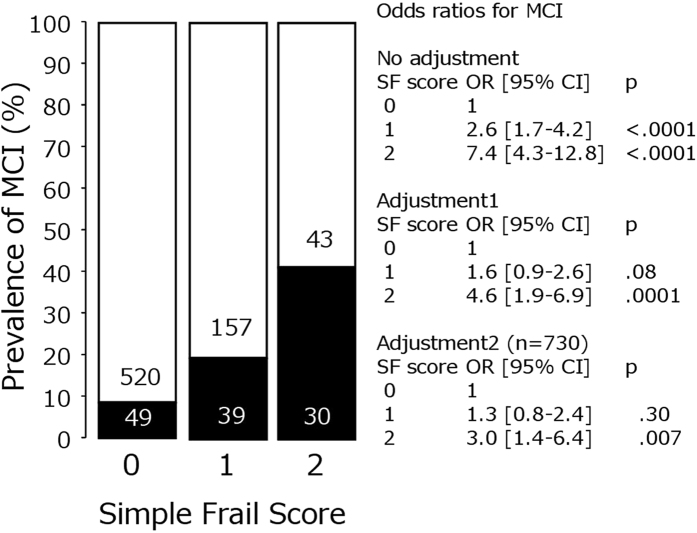
Simple frailty score and the presence of mild cognitive impairment.The closed column indicates the number of participants with mild cognitive impairment (MCI), and the open column indicates those without MCI. The number in the column represents the number of participants. The odds ratio on the right side indicates the odds ratio of a simple frailty (SF) score of 1 and a SF score of 2 to an SF score of 0 for the presence of MCI. Adjustment 1: adjusted for age and sex. Adjustment 2: adjusted for age, sex, body mass index, mean blood pressure, triglyceride, total cholesterol, high-density lipoprotein cholesterol, glucose, insulin, use of antihypertensive drugs, antidyslipidemic drugs, diabetic drugs, current smoking, physical activity and the presence of silent cerebral infarctions and white matter hyperintensity. Adjustment was performed by logistic regression analyses for the presence of MCI. OR, odds ratio; CI, confidence interval.